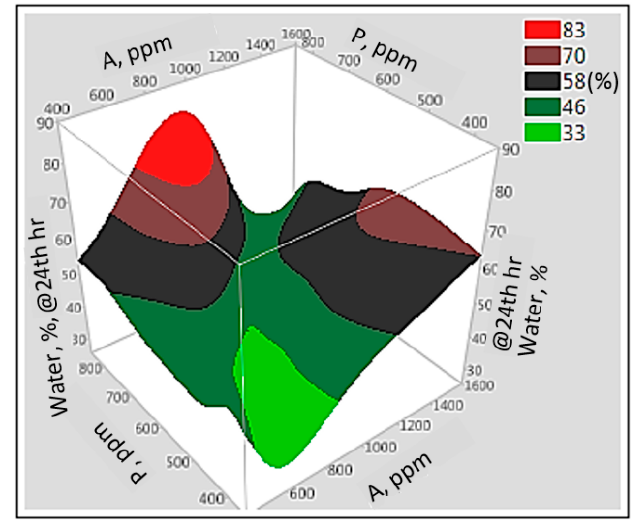
Figure 15. E ff ect of the alkali–polymer on separation. Figure 15. Effect of the alkali–polymer on